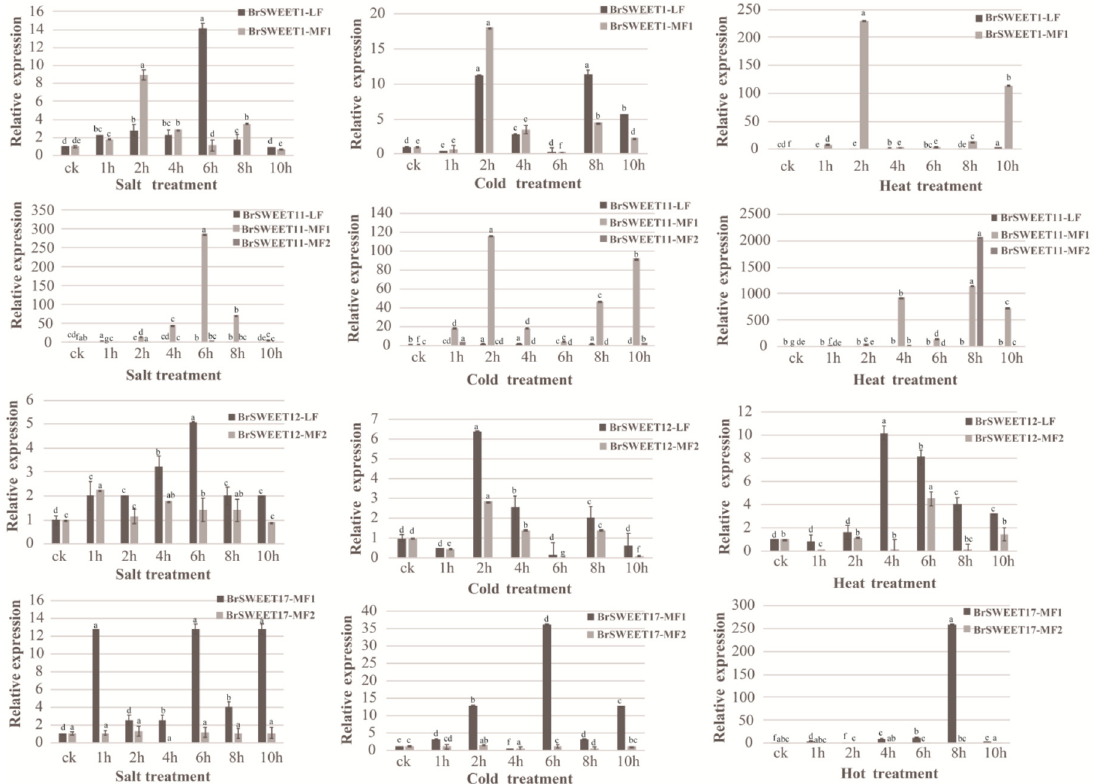
Figure 5. Expression patterns of co-orthologs of SWEETs under salt, cold, and heat stress treatments in B. rapa by RT-qPCR. Error bars represent ± SE ( n = 3). The one-way analysis of variance was calculated by Duncan’s new multiple range test, n = 3; different letters above the bars indicate significant differences ( p < 0.05).